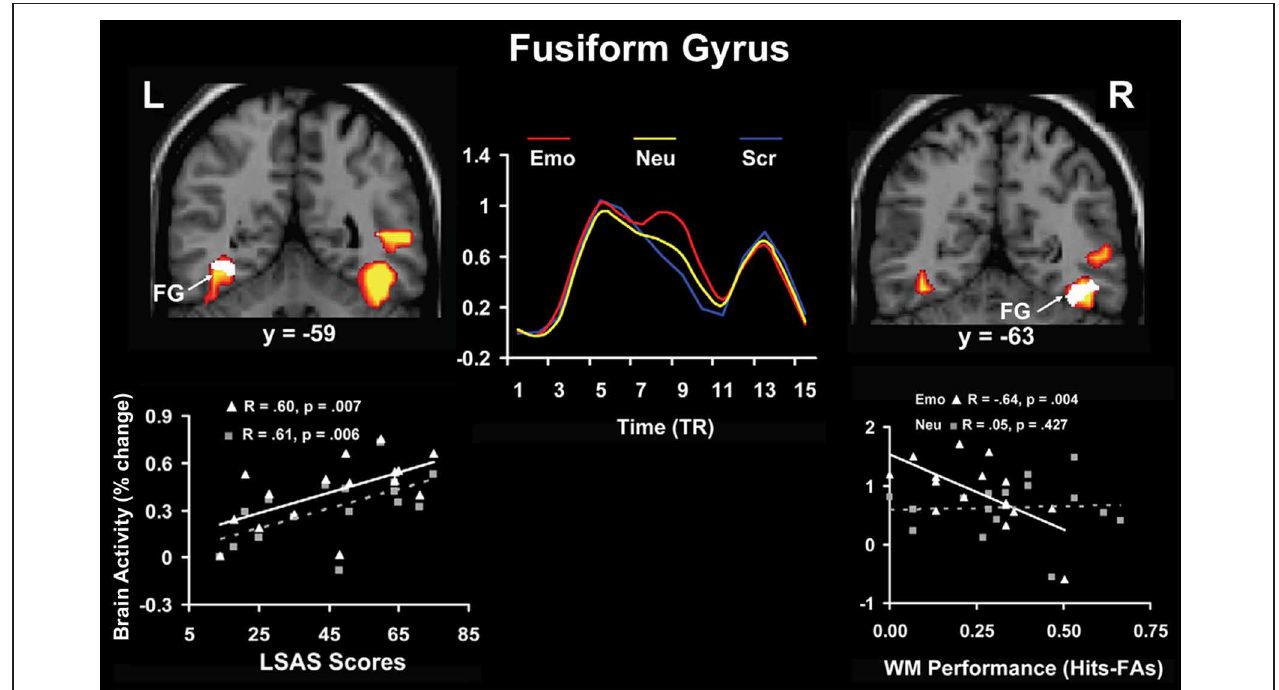
FIGURE 7 | Hemispheric asymmetry linked to bottom-up impact of emotional distraction in the fusiform gyrus (FG). Although these perceptual areas showed bilateral increased activity in response to anxiety-inducing distraction (red clusters and middle time course graph), a dissociation in the bottom-up response could be observed, linked to individual differences in trait anxiety and cognitive performance. Specifically, the left FG showed positive correlation with trait anxiety (white cluster in the left panel), whereas right FG showed negative